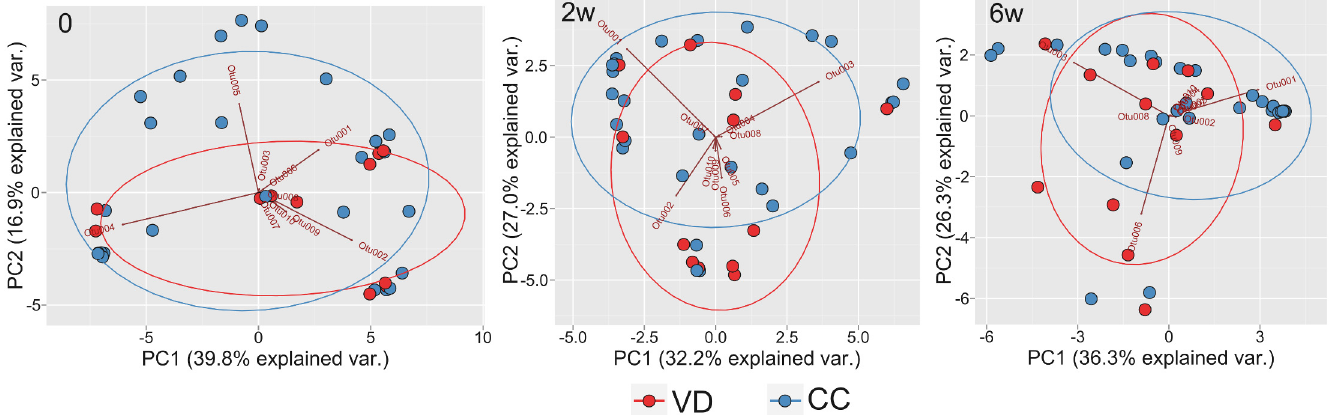
Fig 9. PCA analysis of the infant gut microbiome, categorized according to time points and mode of delivery. Only the ten most abundant OTUs are shown. 0, prior to supplementation; 2w and 6w, 2 weeks and 6 weeks following commencement of supplementation; PC, principal component; var., variation; VD, vaginal delivery; and CC, cesarean